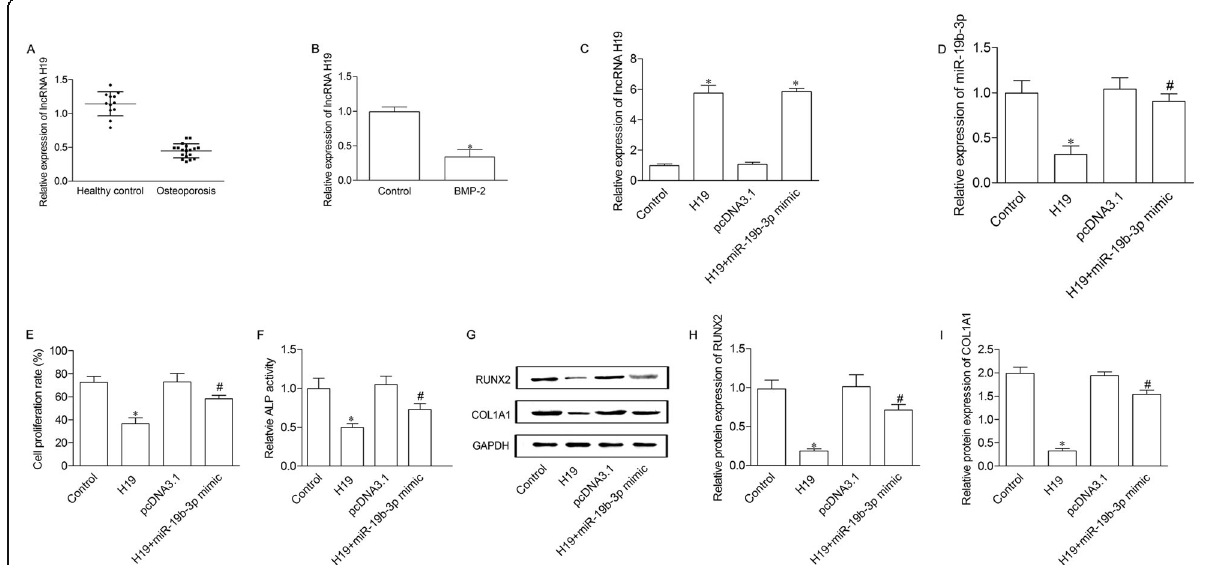
Fig. 4 H19 up-regulation elevates cell proliferation and differentiation of BMSCs through mediating miR-19b-3p. ( a ) The expression of H19 in the serum of postmenopausal osteoporosis patients and heathy controls were measured by qRT-PCR. Each specimen was repeated three times. ( b ) Control group, normal BMSC cell; BMP-2 group, BMSC cell treated with 100 ng/mL BMP-2. * P < 0.05 versus healthy control group. Control group, BMSC cells treated with BMP-2; H19 group, BMP-2 treated cells transfected with pcDNA3.1-H19; pcDNA3.1 group, BMP-2 treated cells transfected with pcDNA3.1 empty vector; H19 + miR-19b-3p mimic, BMP-2 treated cells co-transfected with pcDNA3.1-H19 and miR-19b-3p mimic. H19 ( c ) and miR-19b-3p ( d ) expression were measured by qRT-PCR. ( e ) Cell proliferation was measured by BrdU assay. ( f ) ALP activity was detected in the supernatant of cells. ( g ) Protein expression of RUNX2 and COL1A1 were measured by western blot method. ( h and i ) Relative protein level was